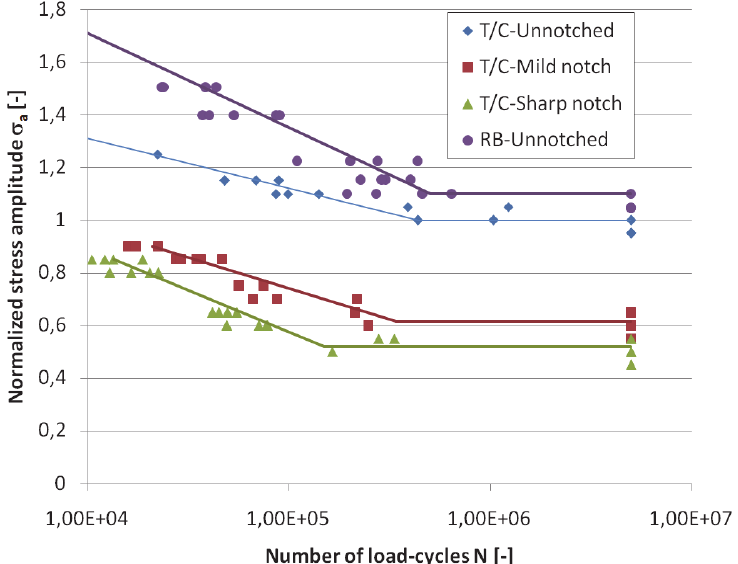
Figure 1. Influence of notch and loading type (Tension/Compression and Rotating Bending) on uniaxial fatigue strength